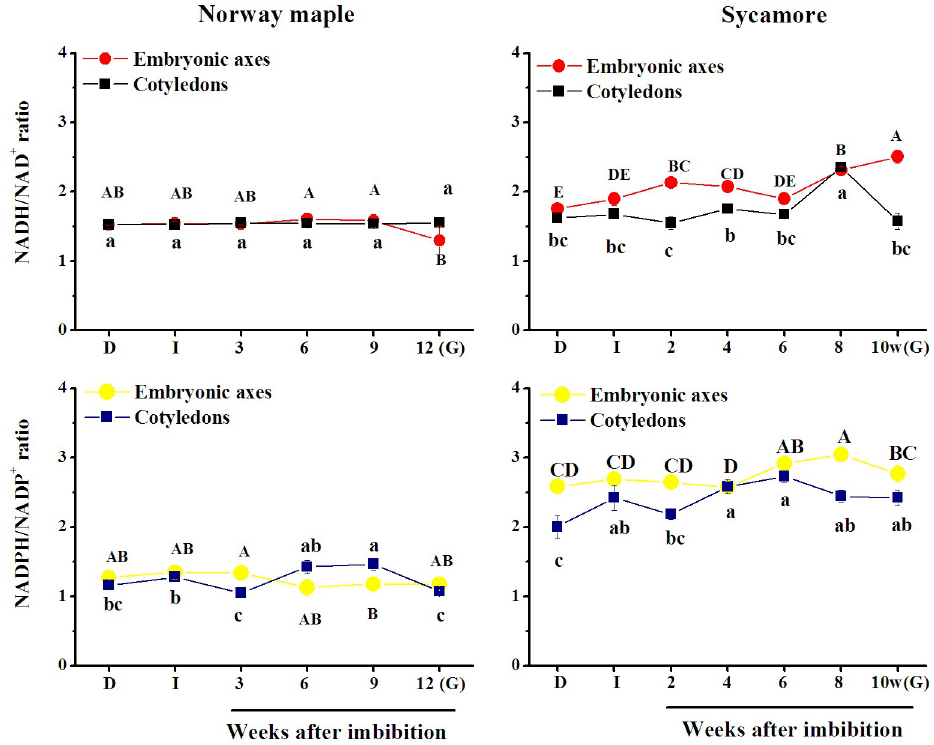
Fig 3. Changes in the ratios of reduced (NAD(P)H) to oxidized (NAD(P) + ) forms of nicotinamide adenine dinucleotide (NAD) and its phosphate (NADP) detected in dry and germinating Norway maple and sycamore seeds. (D) Dry seeds; (I) Imbibed seeds; (G) Germinated seeds. Data represent the mean ± standard deviation of three independent replicates. Statistically significant differences are indicated with different letters (one-way ANOVA followed by Tukey’s test at p � 0.05). The capital letters refer to the embryonic axes.